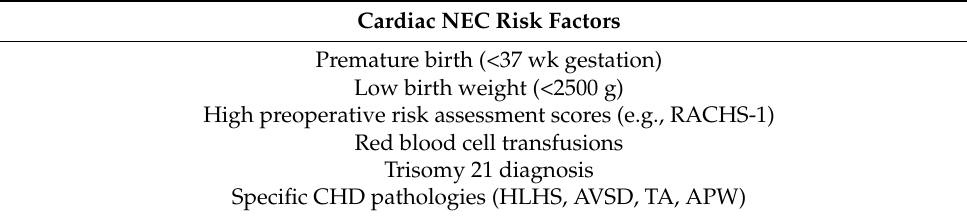
Table 1. Risk factors for cardiac NEC development. Cardiac NEC Risk Factors Premature birth (<37 wk